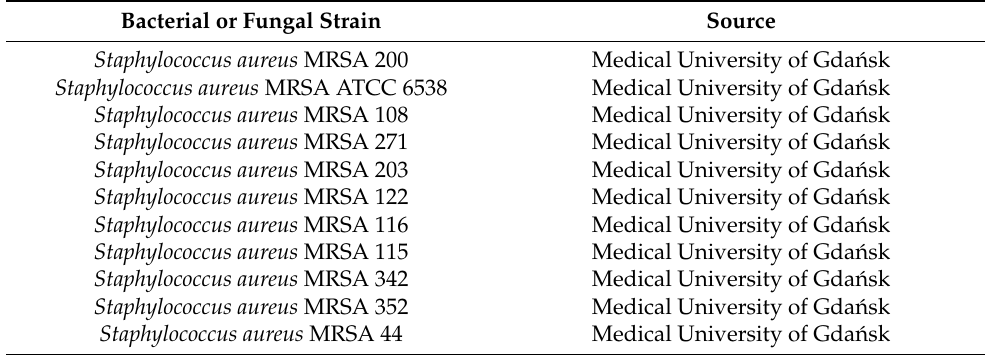
Table 2. Bacterial and fungal strains used for determination of antimicrobial activities of isolated Actinobacteria from the Szczelina Chochołowska